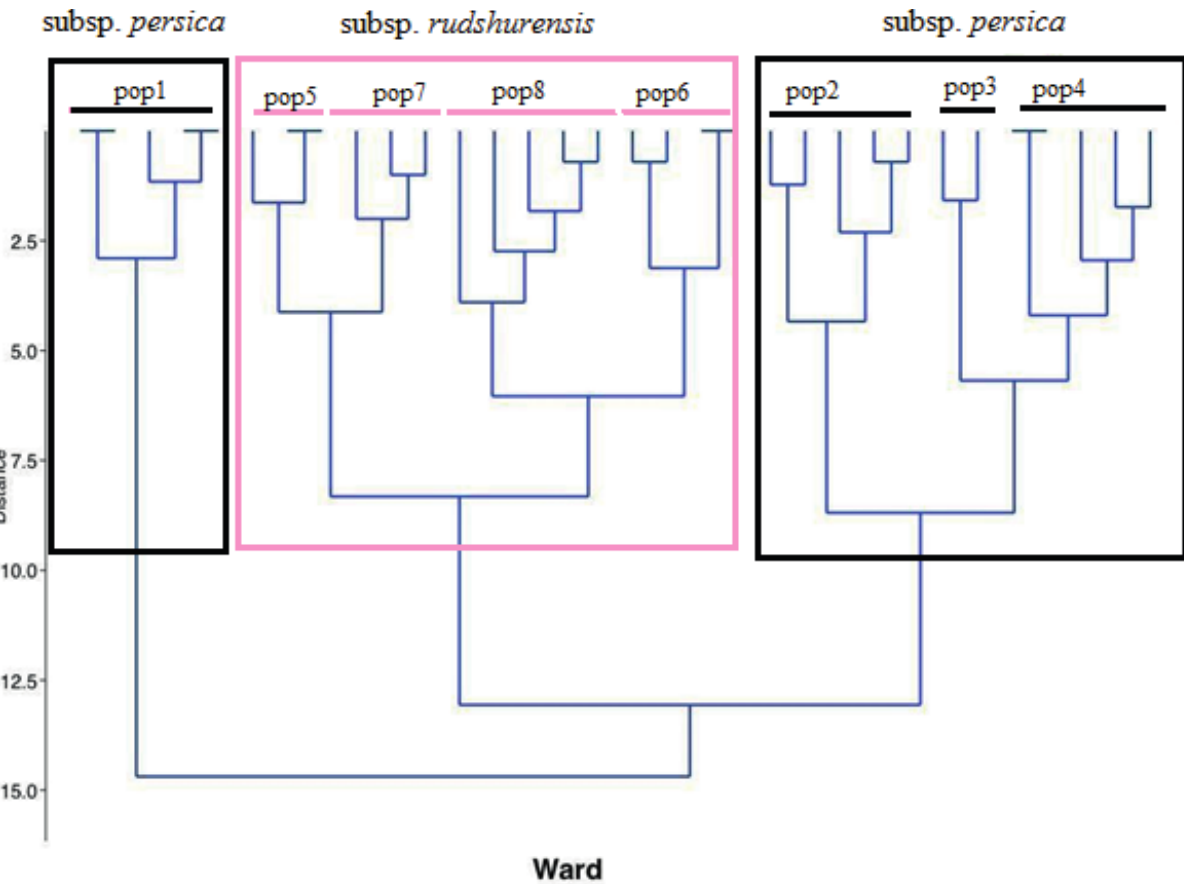
Figure 3. UPGMA plot of populations in Salicornia persica populations based on ISSR data (Population numbers according to Table